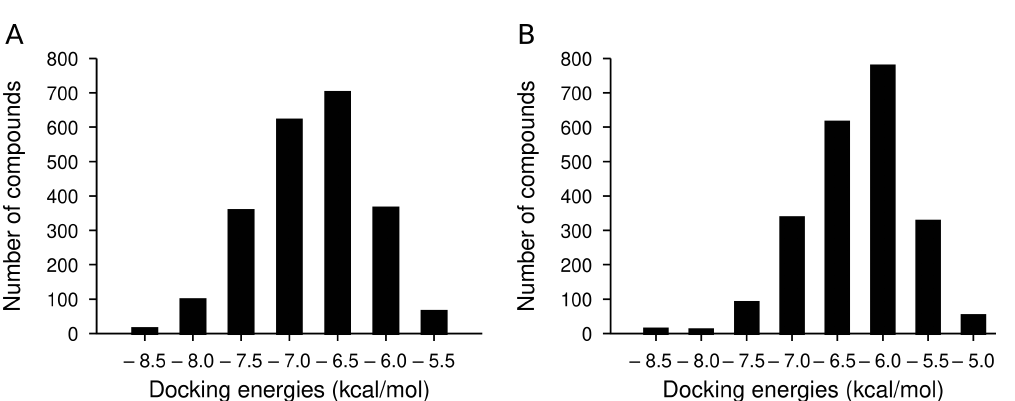
Figure 3. Frequency distribution of docked compounds by their docking energy energies of the 2226 IND analogs against